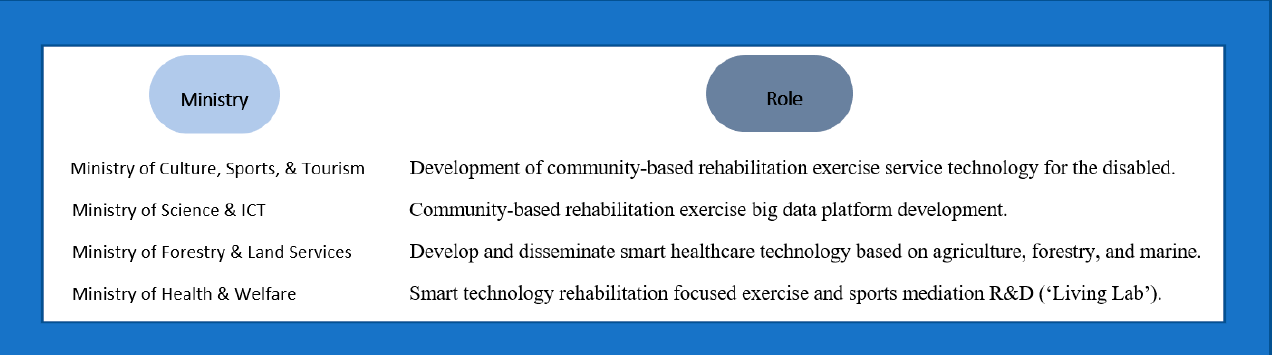
Figure 1. South Korean government ministries and their roles.